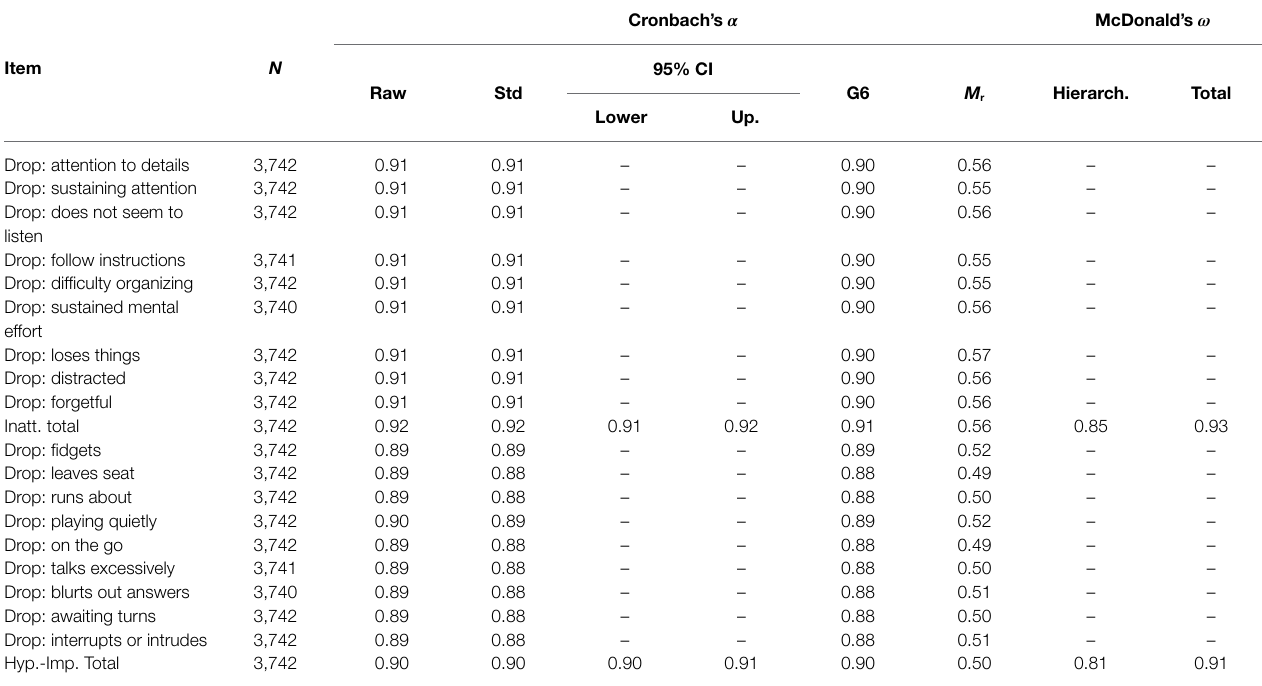
TABLE 1 | Reliability for the symptom items and item drop of the ADHD Rating